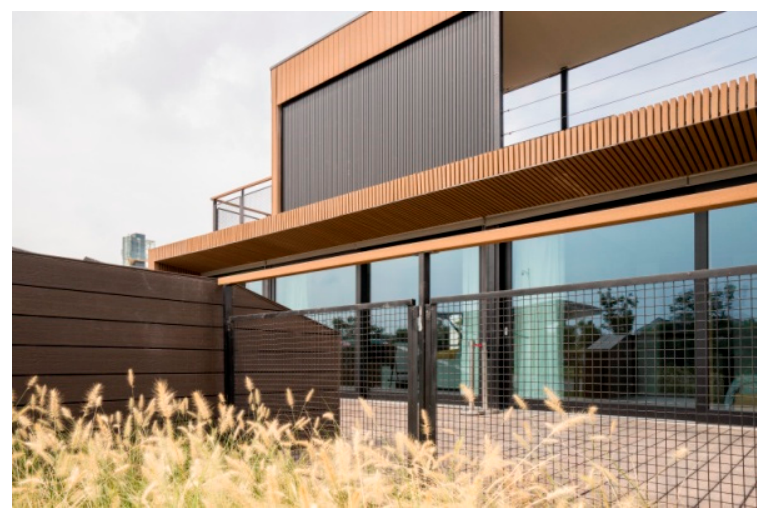
Figure 9. South facade passive solar heat collector air wall.